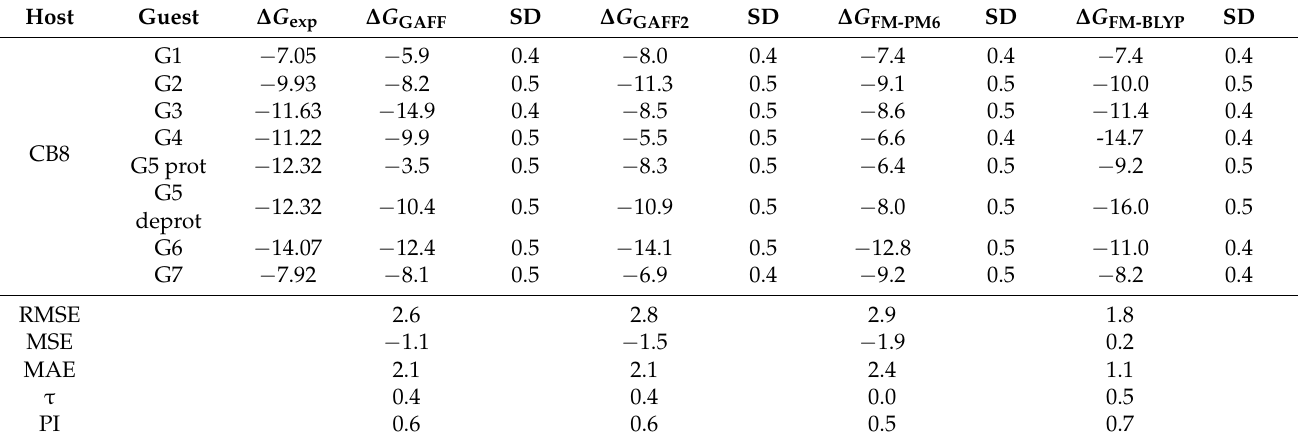
Table 1. The CB8–guest binding affinities in kcal/mol. ∆ G exp is the experimental value. ∆ G GAFF and ∆ G GAFF2 denote the binding affinities obtained with the existing general force fields of GAFF and GAFF2, respectively, while ∆ G FM-PM6 and ∆ G FM-BLYP represent the binding free energies obtained with our newly fitted bonded parameter sets targeting PM6-D3H4X and BLYP-D4/def2-SVP, respec- tively. SD represents the standard error of the free energy estimate, which is obtained from block analysis. MSE, MAE, RMSE, τ , and PI serve as quality measurements. Due to the closeness of the pKa of G5 Ketamine and the pH condition that the experimental binding affinities are measured, the protonated and deprotonated forms of G5 are considered to be approximately equally populated. As a result, the final estimate of CB8-G5 binding affinity is the average of the protonated and deproto- nated G5 results, which is used to calculate the quality metrics, while protonation-dependent results are presented for a detailed comparison of the simulated